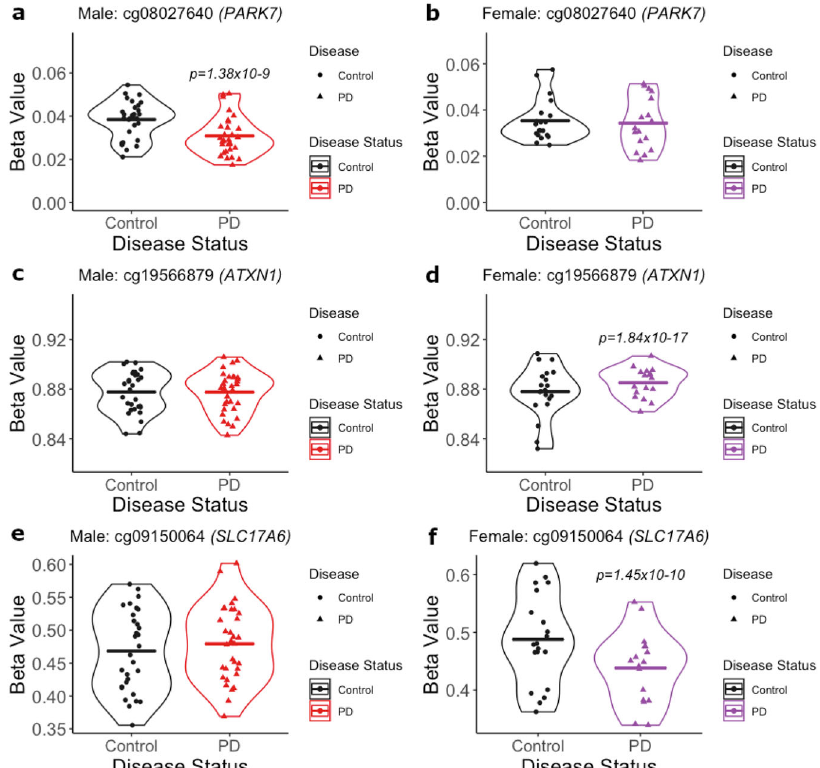
Fig. 2 Dot plots of signi fi cant male and female DMCs by Parkinson ’ s disease. a In males, the most signi fi cant DMC was annotated to the PARK7 locus (cg08027640; p -value = 1.38 × 10 − 9 ). b There was no signi fi cant change in DNA methylation at cg08027640 in females. c There was no signi fi cant change in DNA methylation at cg19566879 in males. d In females, the most signi fi cant DMC was annotated to the ATXN1 locus (cg19566879; p -value = 1.84 × 10 − 17 ). e There was no signi fi cant change in DNA methylation at cg09150064 in males. f In females, a signi fi cant DMC was annotated to the SLC17A6 locus (cg09150064; p -value = 1.45 × 10 − 10 ). P -values indicate signi fi cant change in PD compared to control (cutoff for signi fi cance: p -value < 9 × 10 − 8